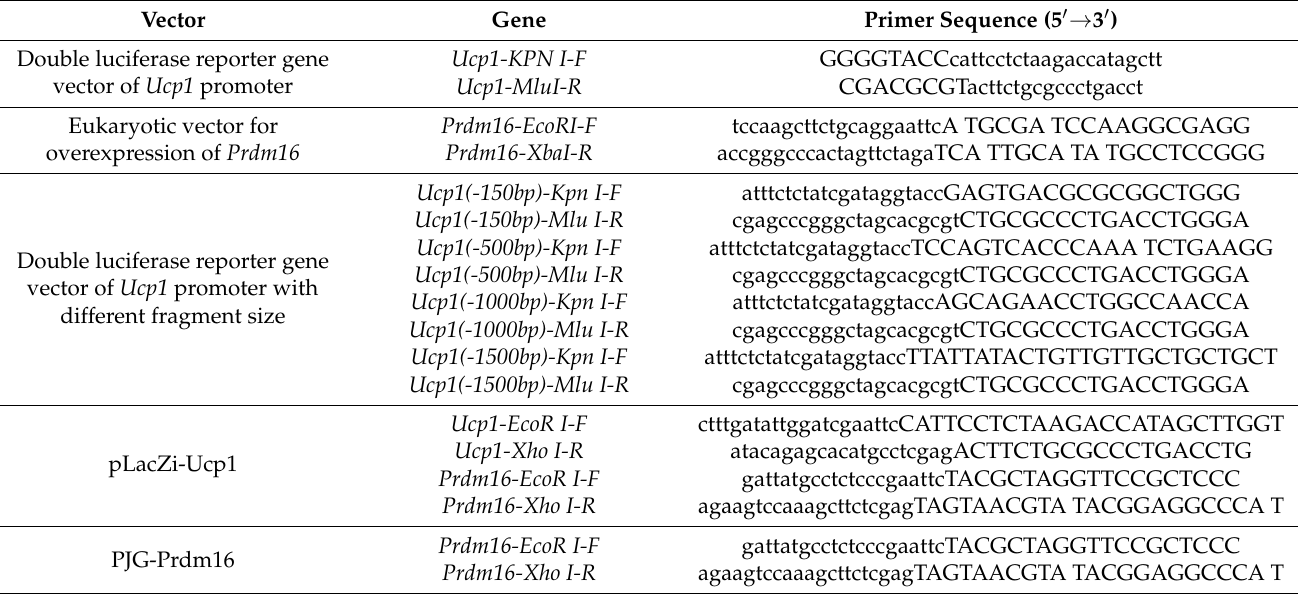
Table 2. The cleavage sites and vector plasmids of the different gene fragments. Vector